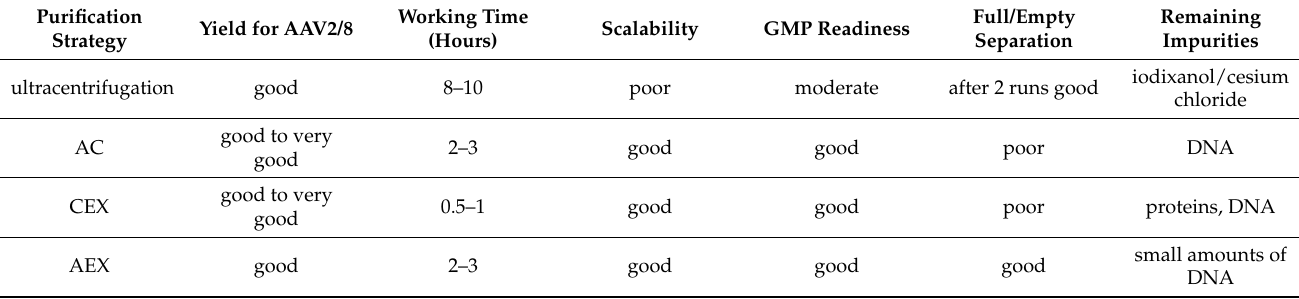
Table 4. Comparison of the ultracentrifugation based und liquid chromatography-based purification of the rAAVs. Purification Yield for Strategy